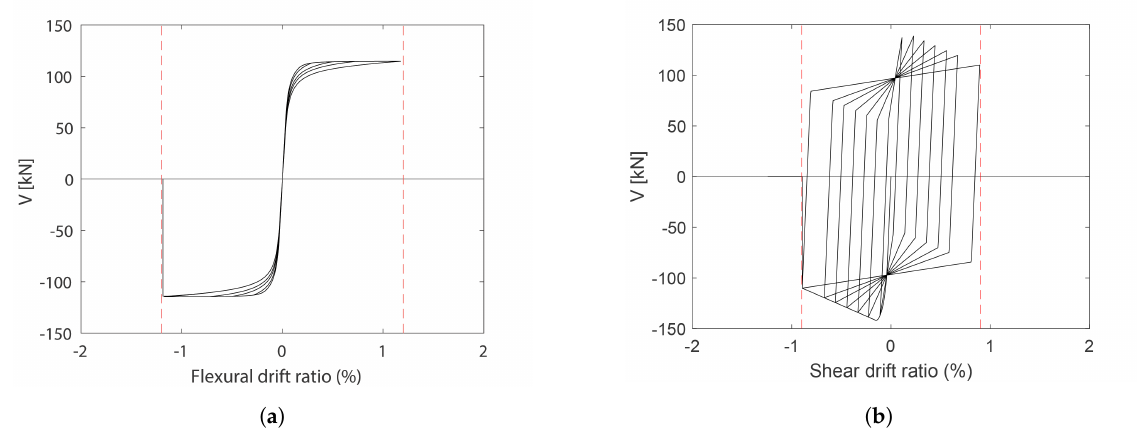
Figure 6. Pier lateral strength and stiffness loss after reaching a collapse drift value. ( a ) Flexural. ( b )